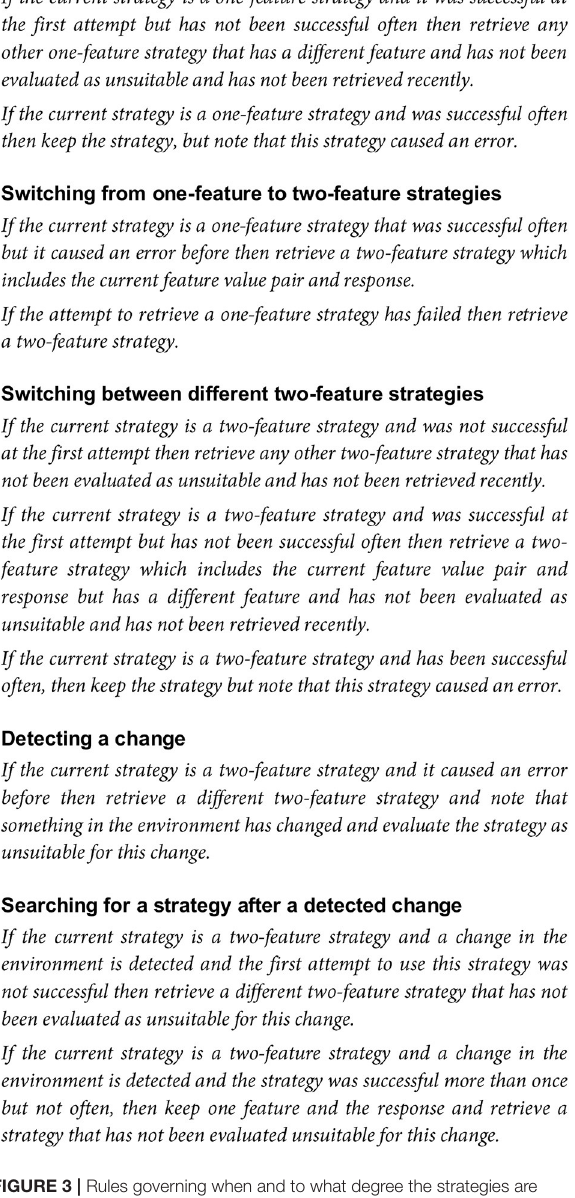
FIGURE 3 | Rules governing when and to what degree the strategies are changed after negative feedback is received.